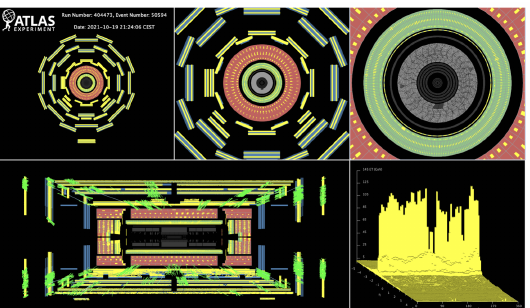
Figure 9. Illustrations of a data event recorded by the ATLAS detector from the LHC beam splashes during the LHC pilot run in October 2021. The proton test beam from the LHC is coming into the ATLAS detector from the right of the picture (showing the A-Side of the detector) travelling to the left (the C-Side). In the image, the yellow boxes show energy deposits in all layers of the ATLAS detector. From the centre moving outwards, the image shows particle interactions in the inner tracking detectors, in the electromagnetic and hadronic calorimeters, and in the muon detectors. The data recorded by ATLAS from the beam splashes during the LHC pilot beam tests in October 2021 were also used to specifically check the performance of the LAr calorimeters after the Phase-1 upgrade. Figure 10a shows the LAr cell energy sums, distributed in a hypothetical tower grid with ∆ η × ∆Φ = 0.025 × 0.025, in the endcap C, in the barrel and in the endcap A. Figure 10b shows the measured SC E T from all layers of the LAr electromagnetic barrel (EMB) and electromagnetic endcaps (EMEC) compared to the summed transverse energies from their constituent calorimeter cells obtained through the main readout path. All these results are obtained using data from a single event of a beam splash run in October 2021. These first data from the LHC gave a confirmation of the good coverage of the detector readout after the upgrade and a confirmation of the good agreement between the energies measured by the new digital trigger readout and by the main readout even with preliminary calibration